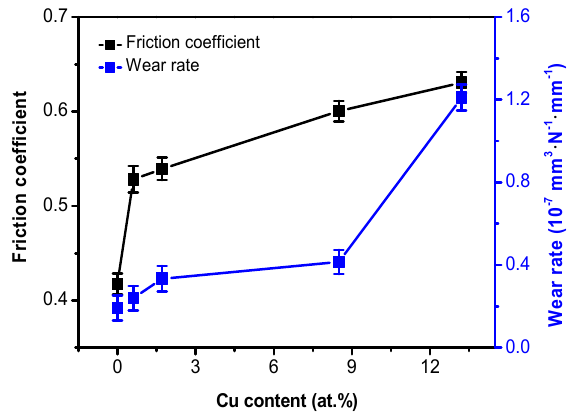
Figure 7. Average coefficient curve and wear rate of VCN–Cu films with different Cu contents at RT.